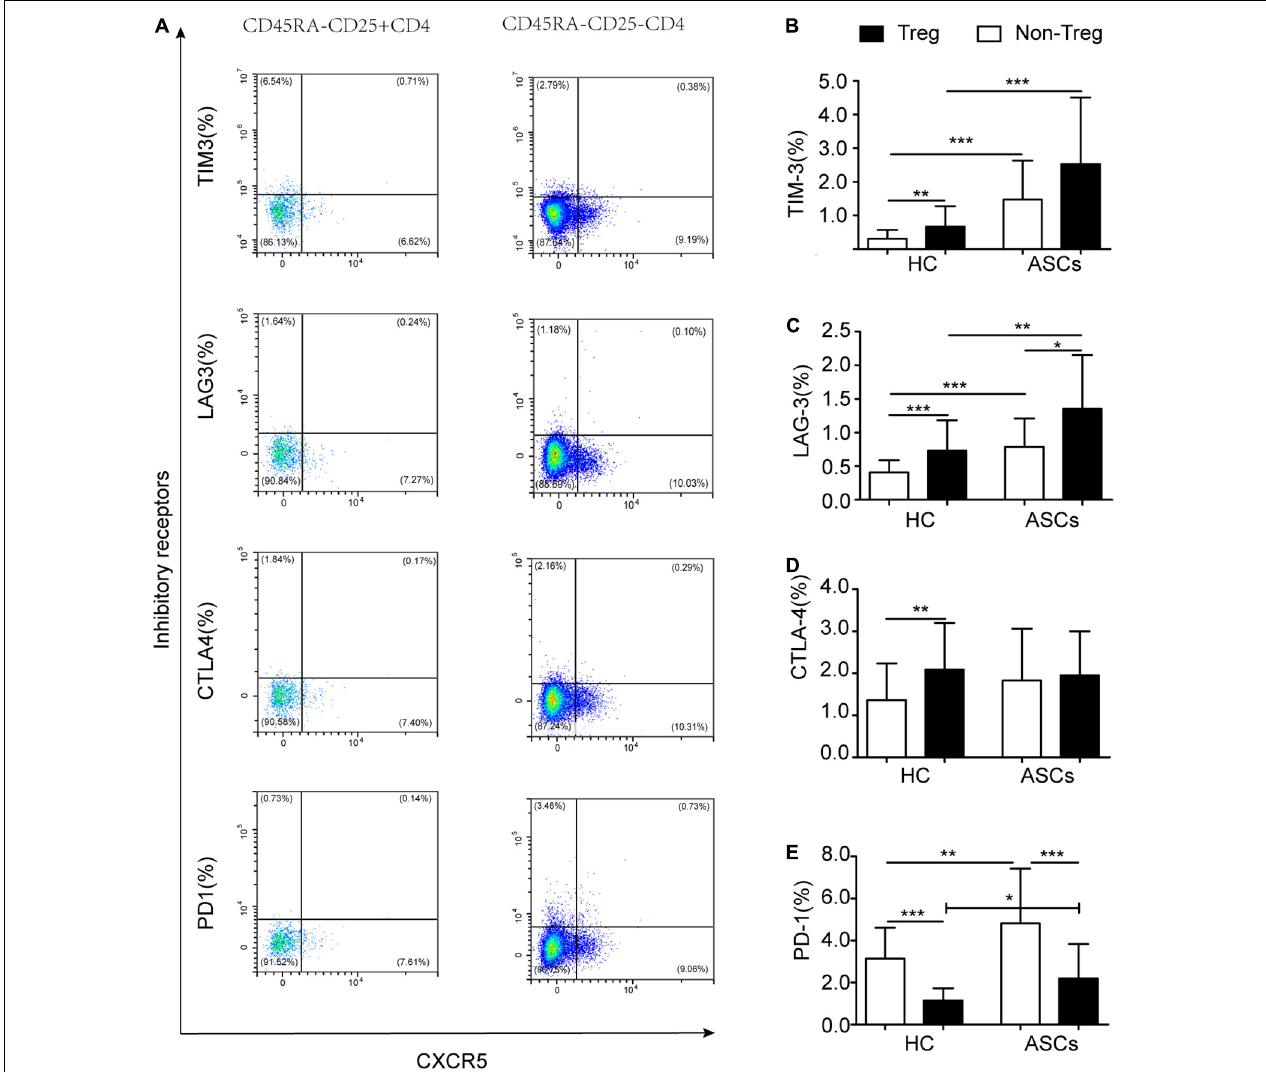
FIGURE 3 | Immune checkpoint molecules expressed on CD45RA − CD25 + CD4 + Treg cells in HBV carriers. (A) Flow cytometry detection of PD-1 + , TIM-3 + , LAG-3 + , and CTLA-4 + on Treg cells. (B–E) Different expressions of PD-1 + , TIM-3 + , LAG-3 + , and CTLA-4 + on Treg cells in ASCs and HC. Data represent the mean ± SD. * P < 0.05, ** P < 0.01, and *** P <